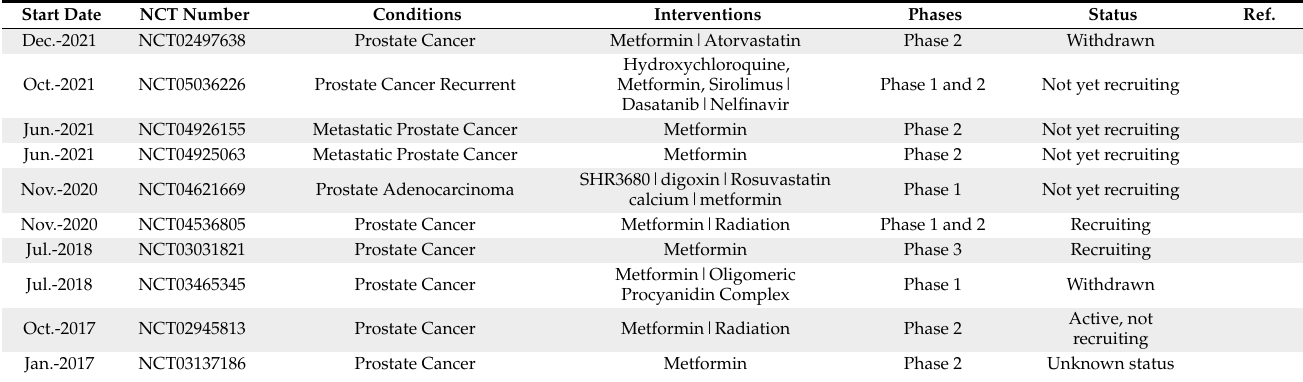
Table 1. Clinical trials for metformin in prostate cancer